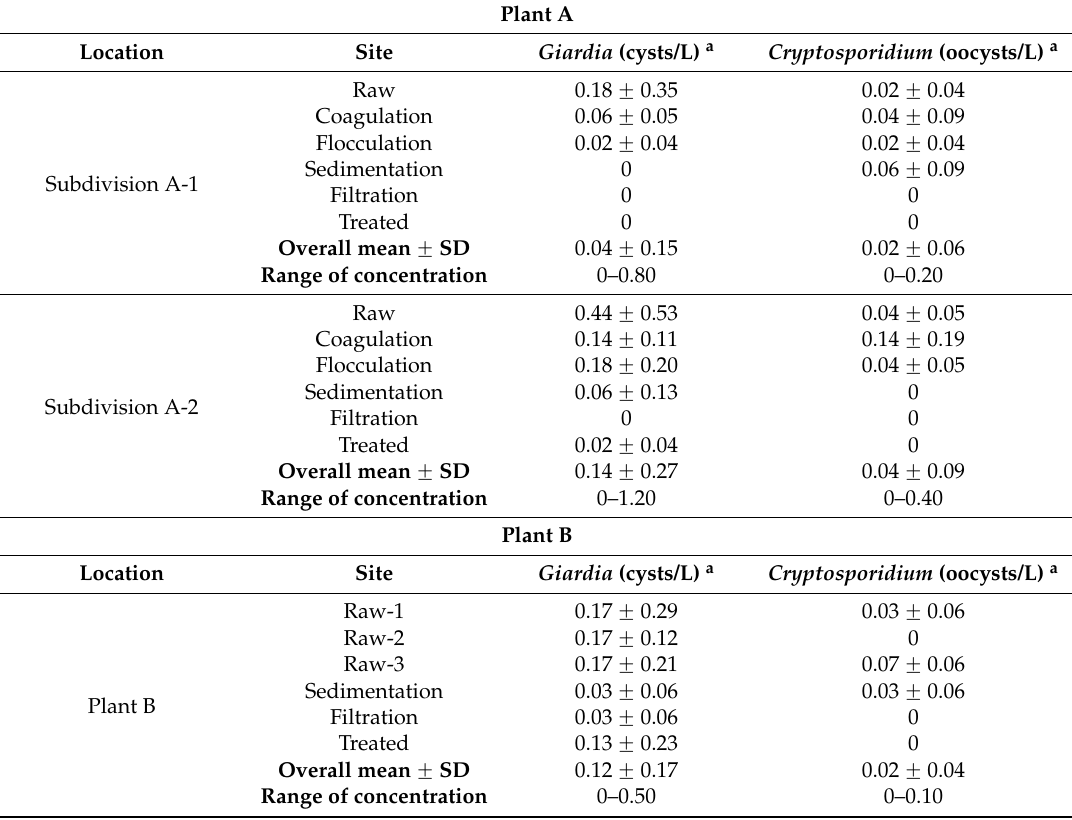
Table 2. Concentration of Giardia cysts and Cryptosporidium oocysts at each treatment